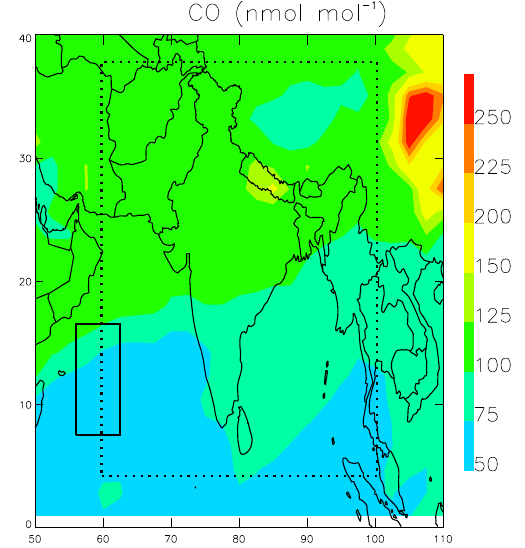
Figure 13. Spatial distribution of CO at 810hPa from MOZART GEOS5 boundary condition data on a typical day (18 June 2008 at 18:00GMT). The WRF-Chem simulation domain is shown as the dotted box. The CO mixing ratios over part of the western boundary, shown by the thick solid box, have been increased by 25% in the simulation 1 . 25 × _BDY.